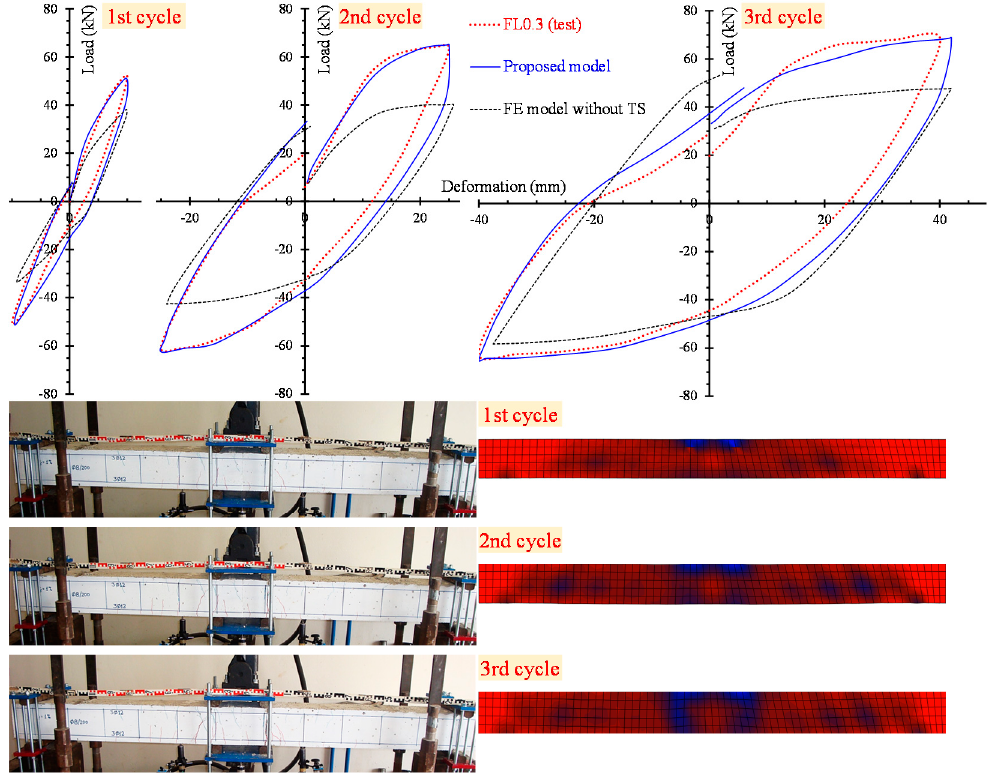
Figure 8. Comparisons between the analytical and experimental results of slender beam FL0.3 in load versus deformation curves and cracking patterns for the 1st, 2nd and 3rd loading cycle.